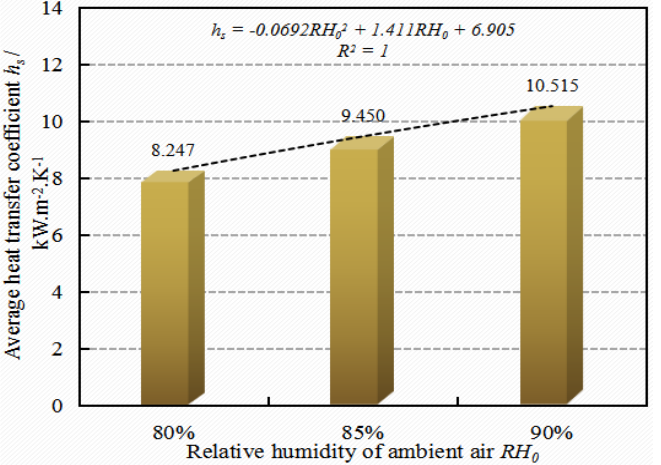
Figure 10. The variations in average s h with different 0 RH values.